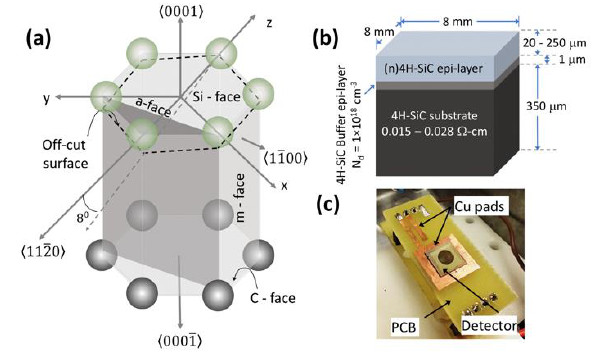
Fig. 1. Schematics showing the (a) crystal faces of 4H-SiC epilayers and (b) the substrate-epilayer configuration used for detector fabrication. (c) Photograph of a typical Ni/4H-SiC detector mounted on a PCB. The circular Ni Schottky and the square back contacts are also